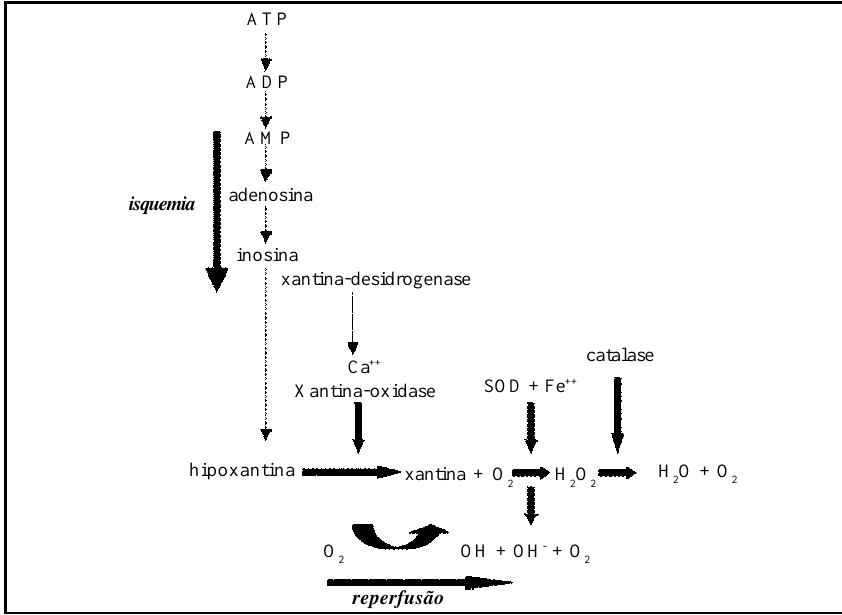
FIGURA 2 - Mecanismo de produção de radicais livres pela ação da